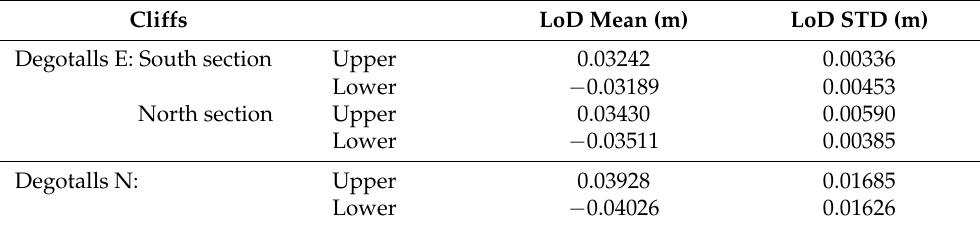
Table 7. Statistical summary of the results of calculating the LoD in both Degotalls cliffs. This table summarizes the 13 comparisons in Degotalls E (12 in the South section and 1 in the North section) and 2 comparisons in Degotalls